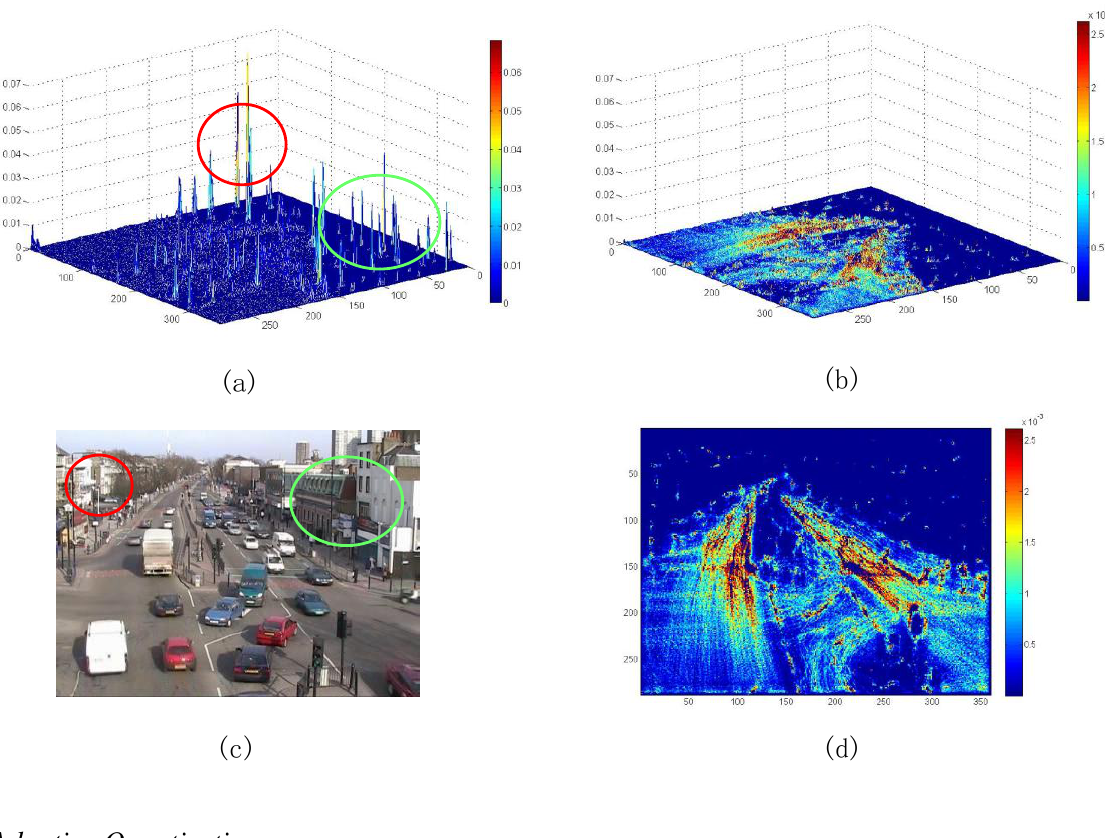
Figure 2. Optical flow spatial distribution. ( a ) 3D map without and ( b ) with statistical denoising; ( c ) scene image; ( d ) 2D map with statistical